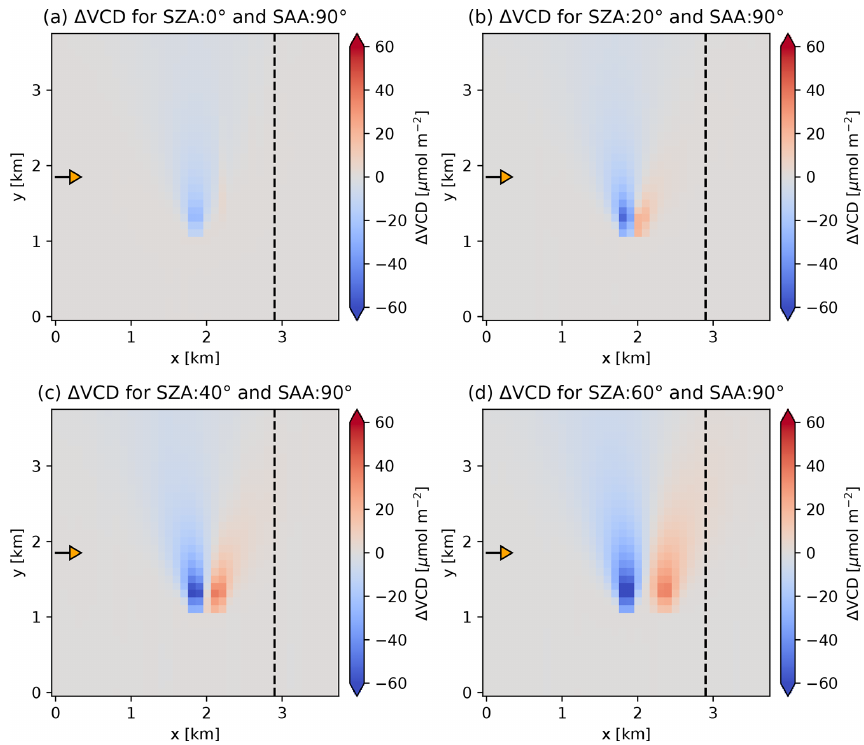
Figure 10. Absolute difference between total VCD from synthetic SCD and 1D box AMF with solar zenith angles (SZA) of (a) 0 ◦ , (b) 20 ◦ , (c) 40 ◦ and (d) 60 ◦ and the true total VCD. Table 2. Estimated NO 2 emissions from the retrieved VCD fields obtained from 1D-layer AMFs under different solar zenith angle (SZA) and solar azimuth angles